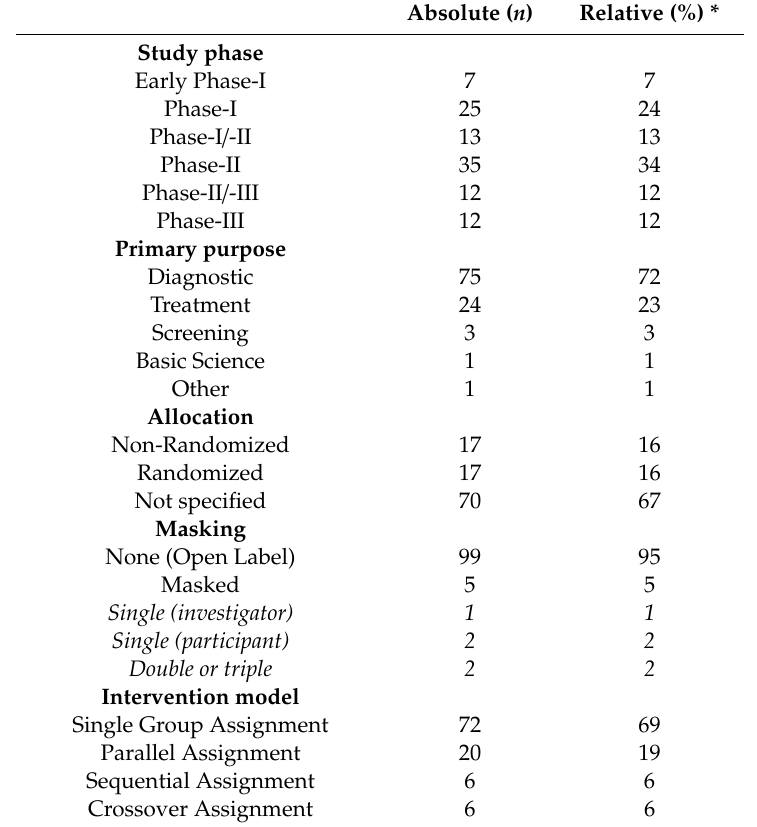
Table 3. Study type and study design specific parameters of the included clinical prospective trials with PSMA-radioligands for prostate cancer from the ClinicalTrials.gov registry ( n =